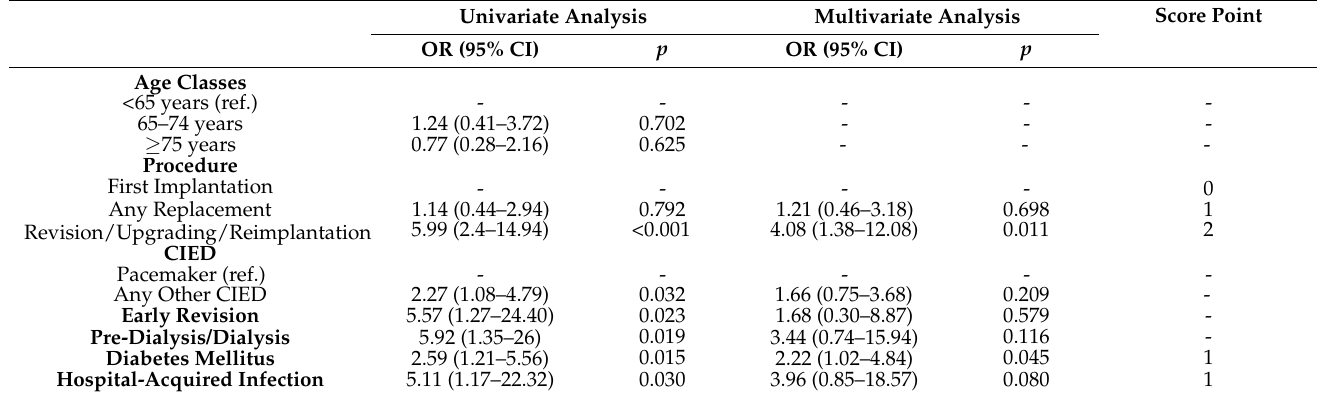
Table 3. Logistic regression analysis for CIED infection occurrence.